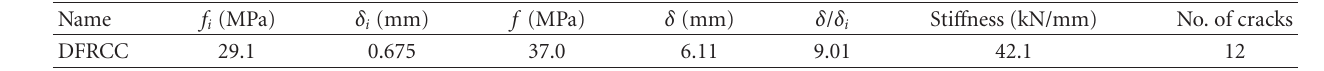
Table 4: Experimental results for DFRCC panel specimens.